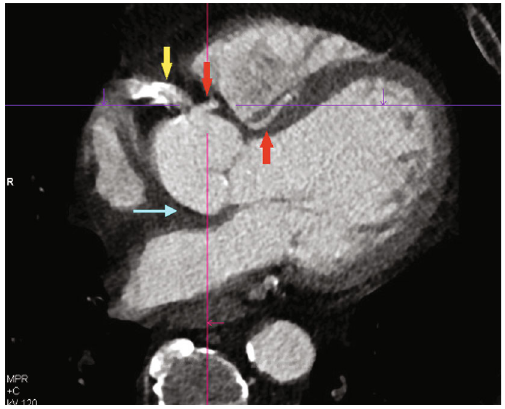
Figure 3: Coronary CT showed the absence of a left coronary system (blue arrow), a large calci fi ed RCA originating posteriorly from the right coronary cusp (yellow arrow), and a small LAD artery originating from the right coronary cusp into the interventricular groove (red arrows).